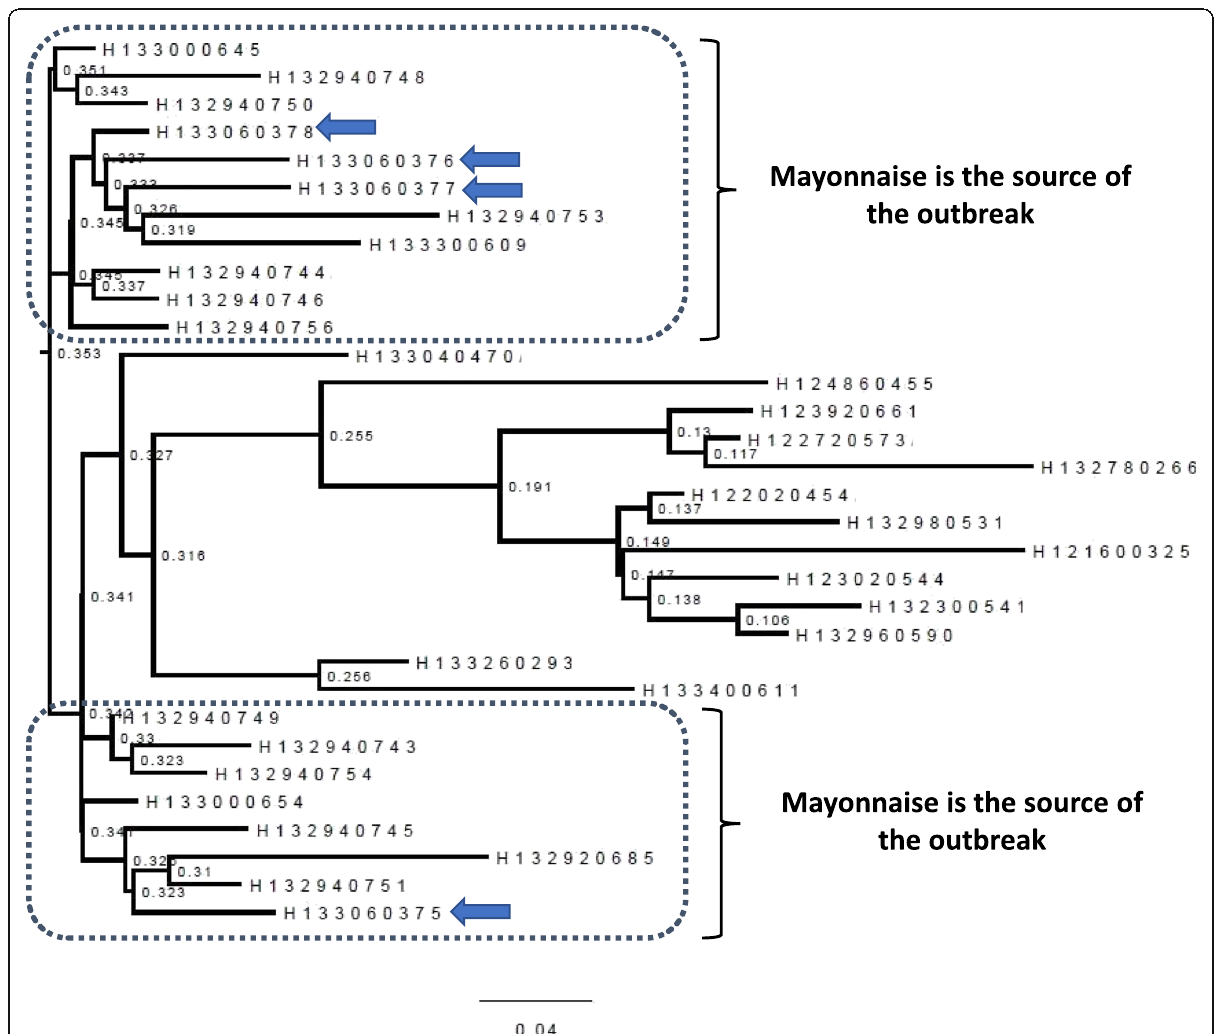
Fig. 1 Maximum likelihood phylogenetic tree of Salmonella Typhiurium strains based on single nucleotide polymorphisms determined from whole genome sequences. The scale represents the number of nucleotide substitutions per site. Bootstrap support values, given as a percentage of 1000 replicates, are shown on the branches. The tree shows conclusively that myonaise (marked with arrows) is the source of